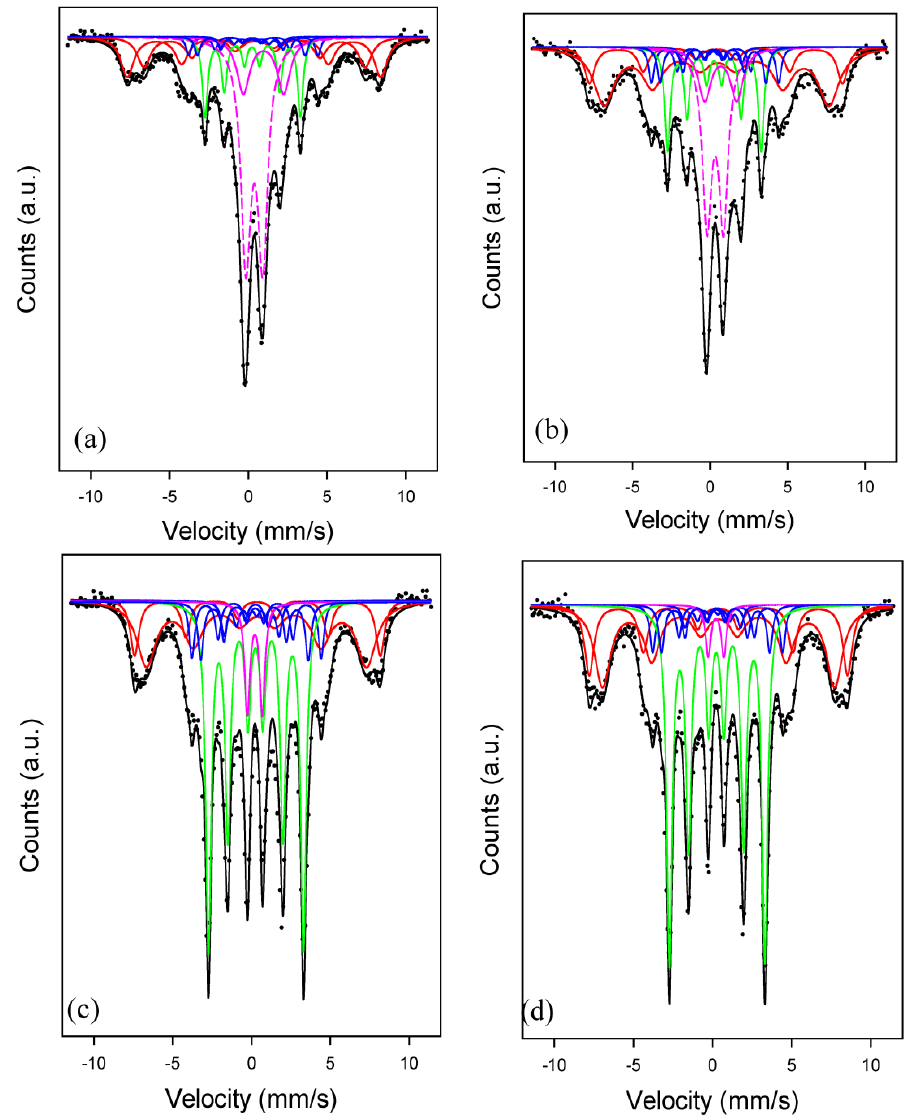
Figure 6. Mossbauer spectra of carbided ( a ) Fe/700AlSi, ( b ) Fe/900AlSi, ( c ) Fe/1100AlSi, and ( d ) Fe/1200AlSi. Spectra were recorded at 20 K. The passivated reduced catalysts were carbided at 280 °C in H 2 /CO = 1.